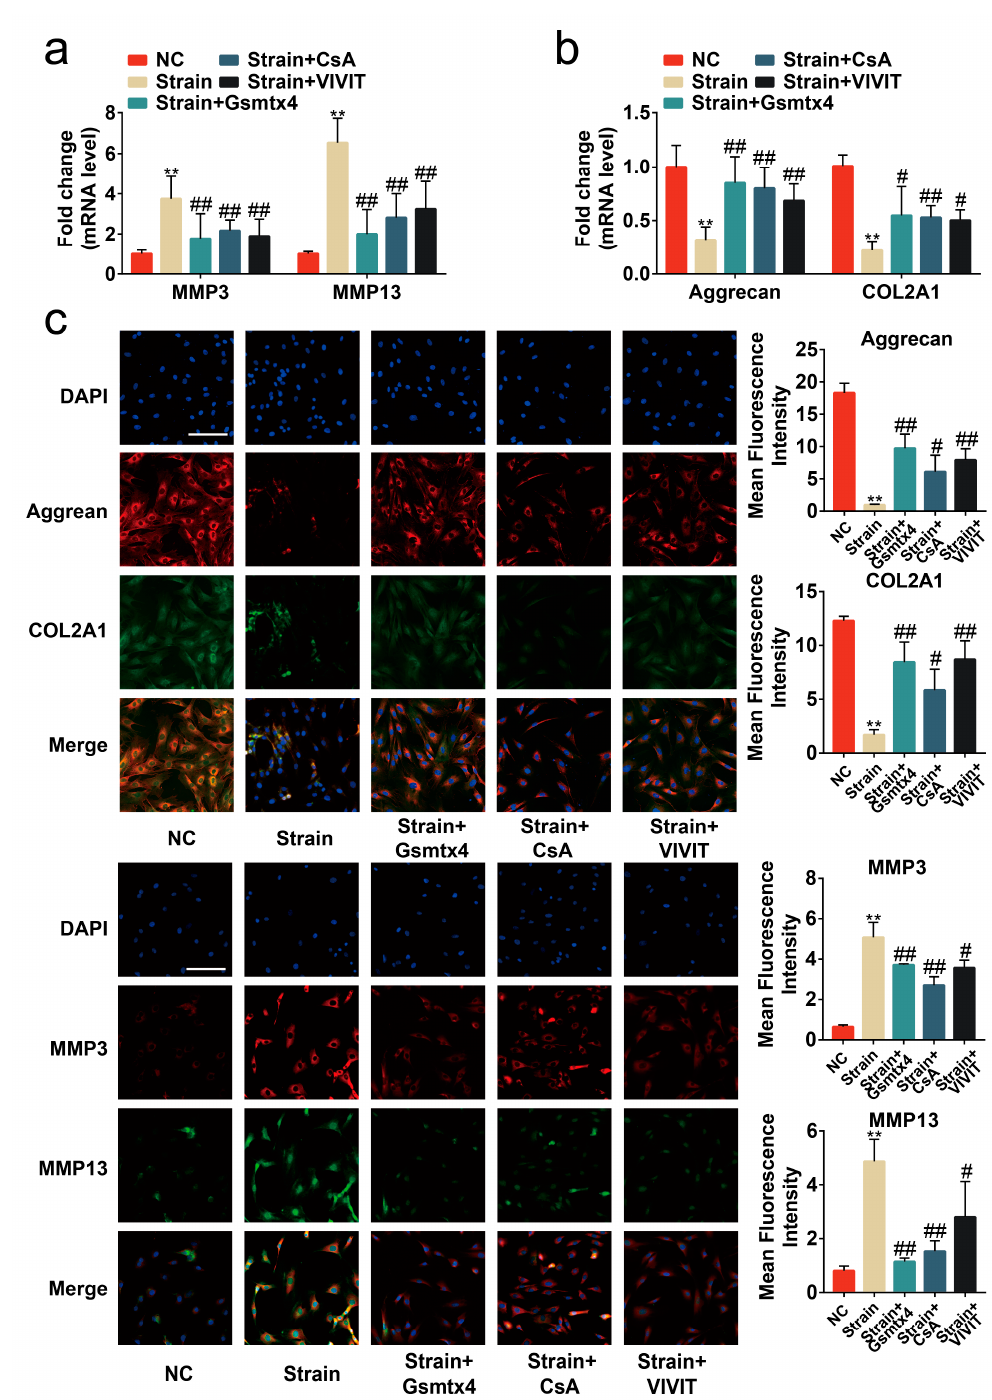
Figure 6. Blocking the signal transduction of the CaN/NFAT1 signaling axis protected chondrocytes from anabolic/catabolic imbalance. ( a , b ) mRNA levels of Aggrecan, COL2A1, MMP3, and MMP13 in chondrocytes determined by RT-qPCR ( n = 3). ( c ) Immunofluorescence staining and quantified results of MMP3, MMP13, Aggrecan, and COL2A1 in chondrocytes ( n = 3). ** p < 0.01 vs. NC; # p < 0.05 vs. strain; ## p < 0.01 vs. strain;. Scale bar: 100 μ m. One-way ANOVA with Bonferroni’s test for ( a – c ), Kruskal–Wallis test with Dunn’s multiple comparisons test for COL2A1 in ( b ).